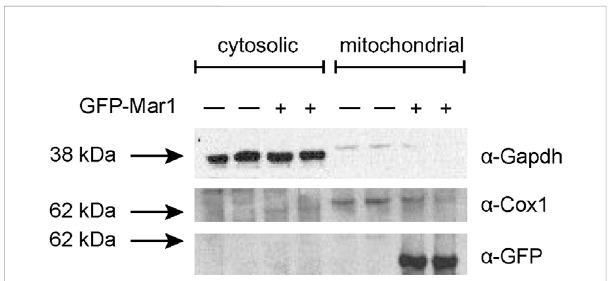
FIGURE 2 Mar1 mitochondrial localization analyses. Mitochondrial fractionations were performed on the WT strain and the GFP-Mar1 strain following incubation in YPD medium. Normalized cytosolic and crude mitochondrial lysates were separated by SDS-PAGE and western blots were performed probing for Gapdh with an anti-Gapdh antibody, Cox1 with an anti-Cox1 antibody, and GFP-Mar1 with an anti-GFP antibody. The numbers to the left of the blot represent molecular weight in kilodaltons (kDa). The approximate size of Gapdh is 35 kDa. The approximate size of Cox1 is 60 kDa. The approximate size of GFP-Mar1 is 60